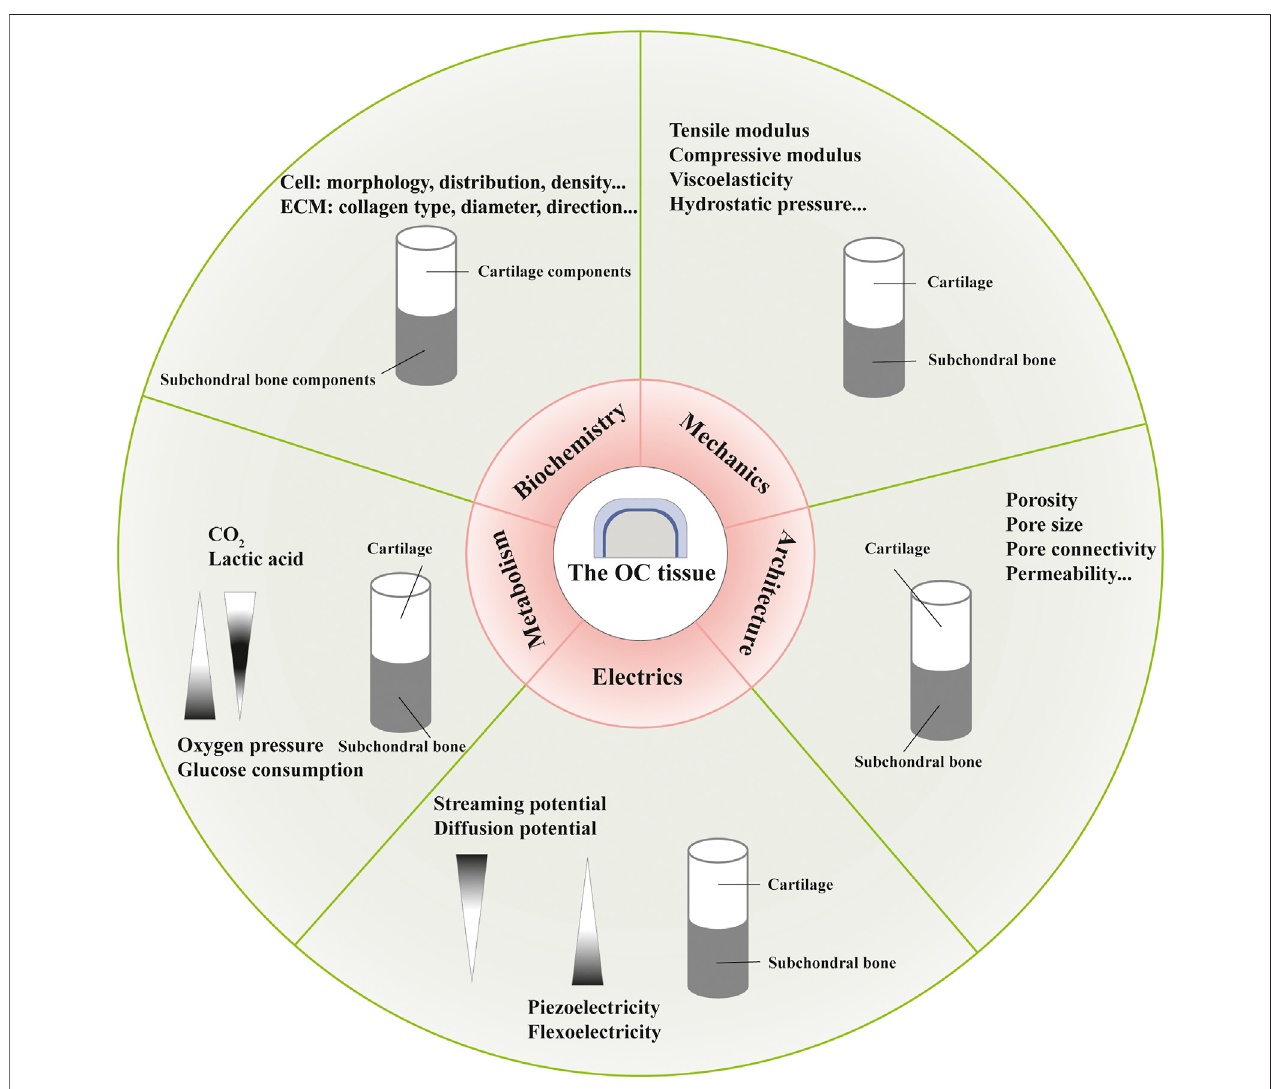
FIGURE 2 | Different gradients in the osteochondral (OC) tissue with regard to biochemistry, mechanics, architecture, electrics and metabolism.